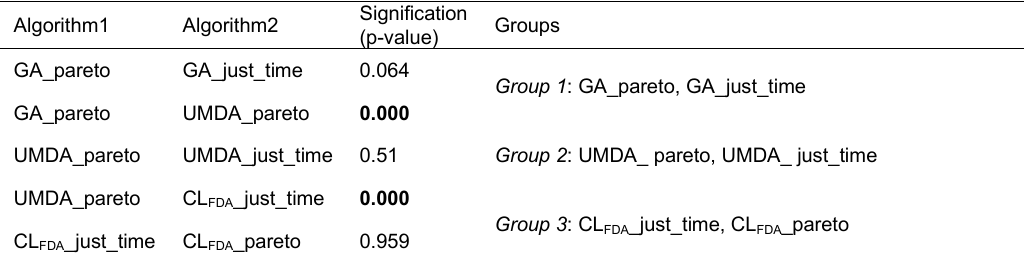
Table 16. Comparison results using Wilcoxon test, variable